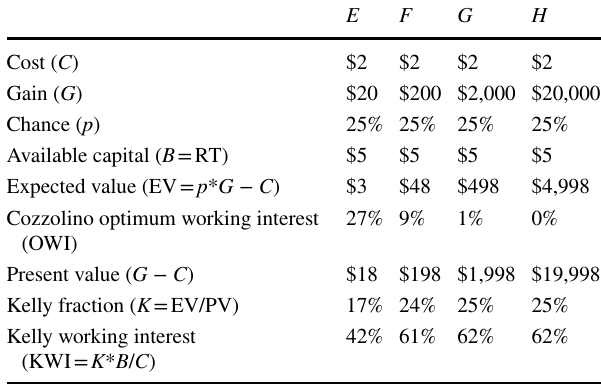
Table 2 Cozzolino and Kelly optimum working interest in four